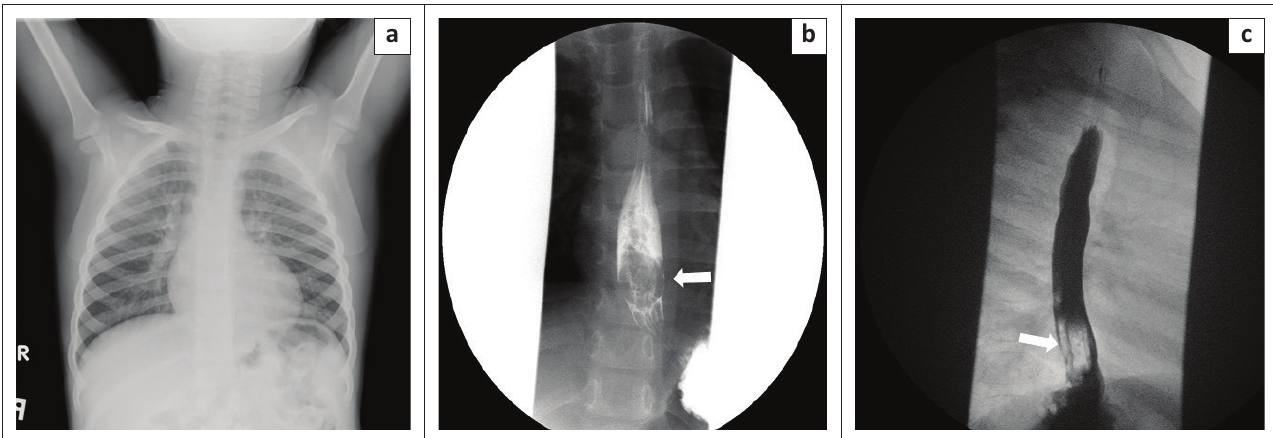
FIGURE 10: Images of a 3-year-old child who ingested a toy part (toy car tyre). The chest radiograph (a) was unremarkable. Upper oesophagogram, frontal (b) and oblique (c) views, showed a ring-shaped filling defect in the lower oesophagus, immediately proximal to the gastro-oesophageal junction with contrast traversing into the stomach without any